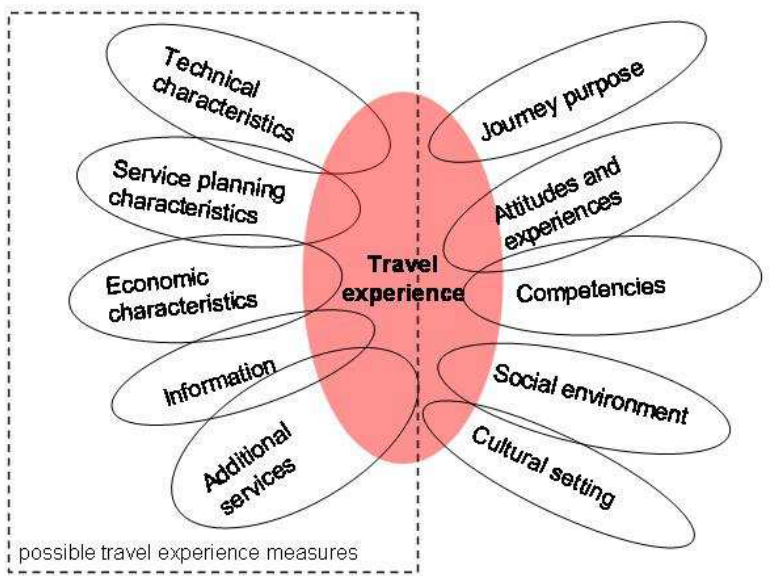
Figure 1. Influences on the travel experience and “measures” to influence it (author’s depiction) This definition implies also that these activities are conducted by, on behalf of or at least with the consent of the service provider, although the travel experience can of course be shaped by the passengers themselves as well (cf. Watts 2008, Currie/Stanley 2008, p.540 seq.). It also implies a link to a concrete journey, hence general marketing/publicity activities conducted by transport providers, for instance through advertising, would not be